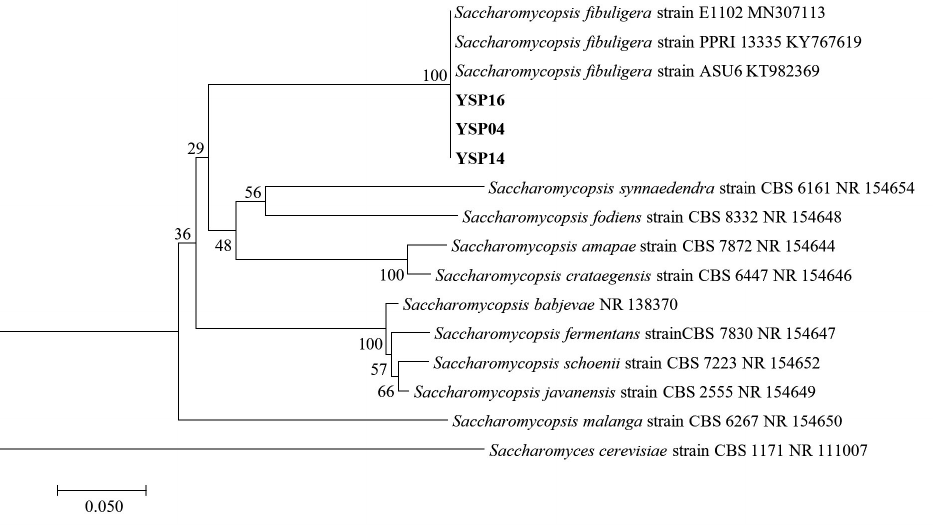
Fig. 4.(B). A phylogenetic tree of 3 isolates of Saccharomycopsis fibuligera (YSP04, YSP14 and YSP16) constructed with the dataset based on ITS gene sequences. The tree was generated from Neighbor Joining Analysis (NJ), and NJ Boostrap (NJBS) values were calculated and shown on the